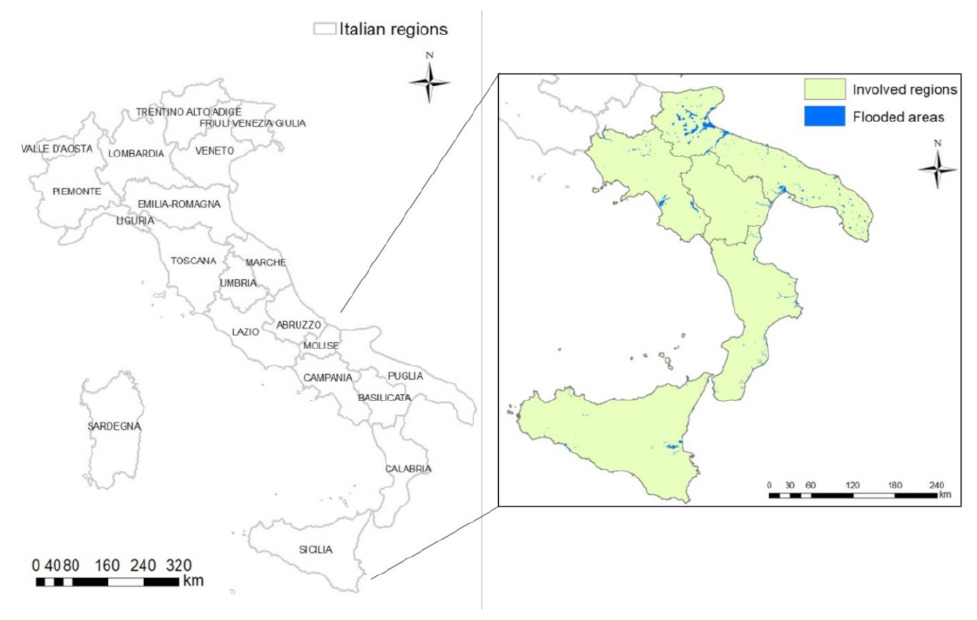
Figure 3. Representation of all Italian regions and focus on those involved in the European project [30], with the historically flooded